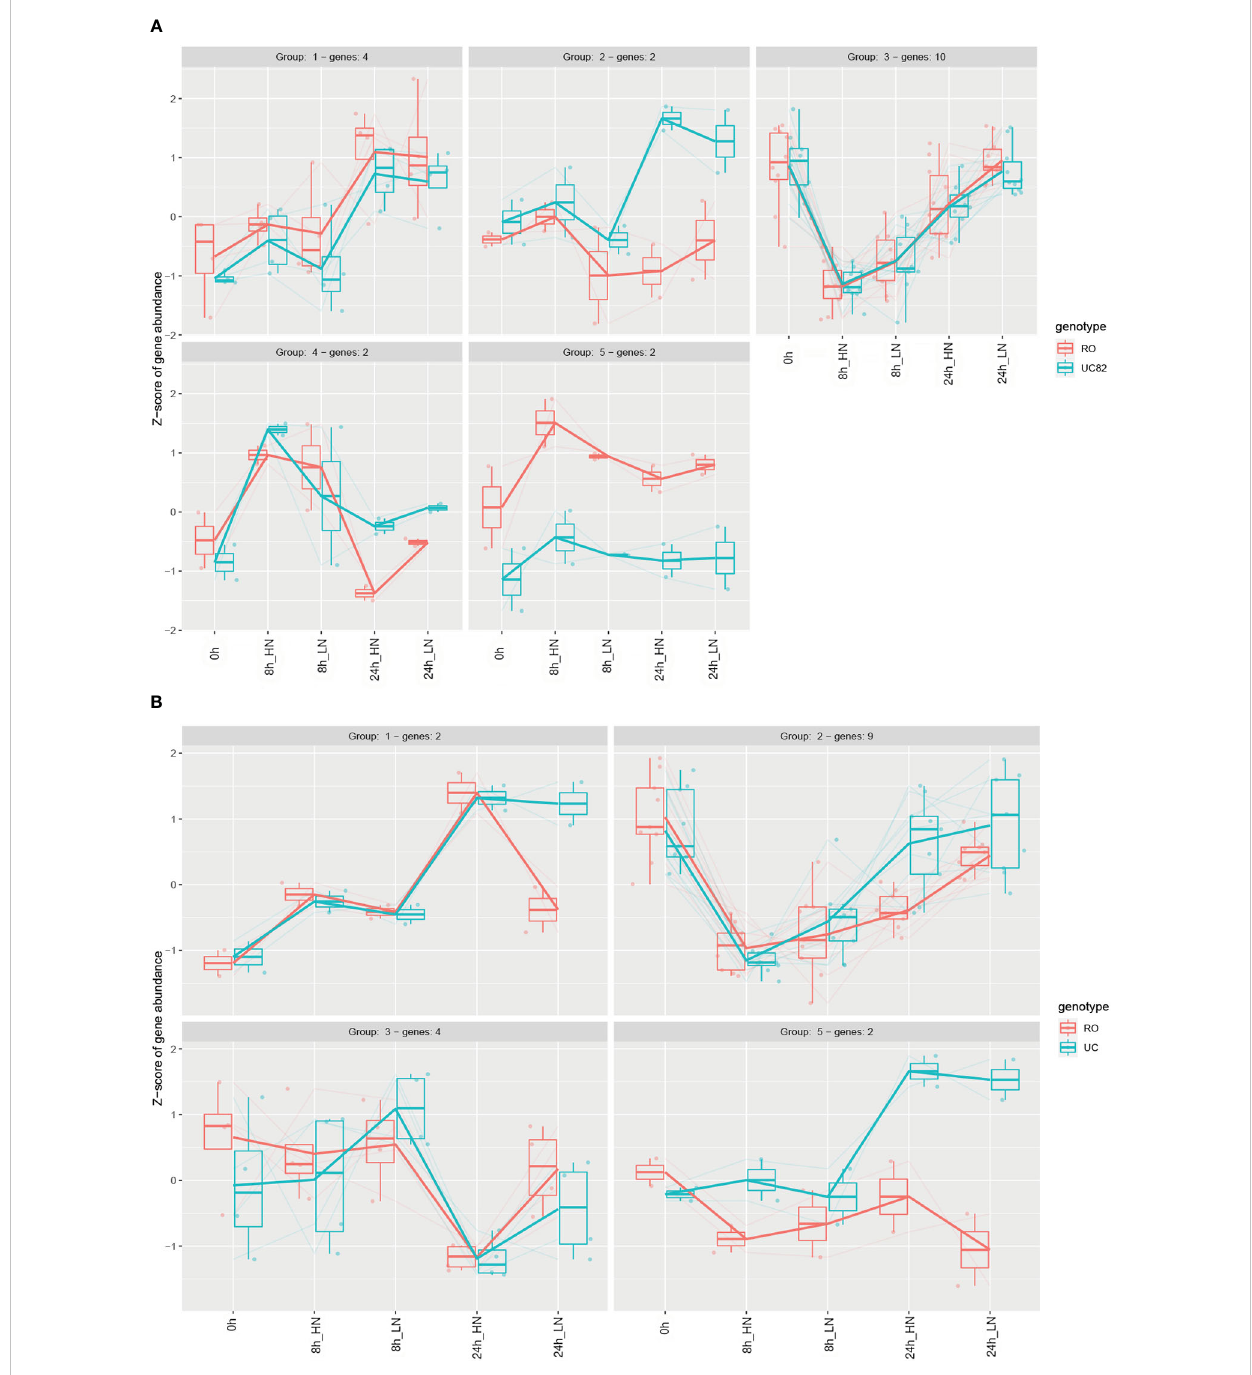
FIGURE 6 Expression pro fi les of the differentially expressed NPF genes in shoot (A) and root (B) . Genes were clustered through the DEGreport R package using Variance Stabilized Transformed (VST)